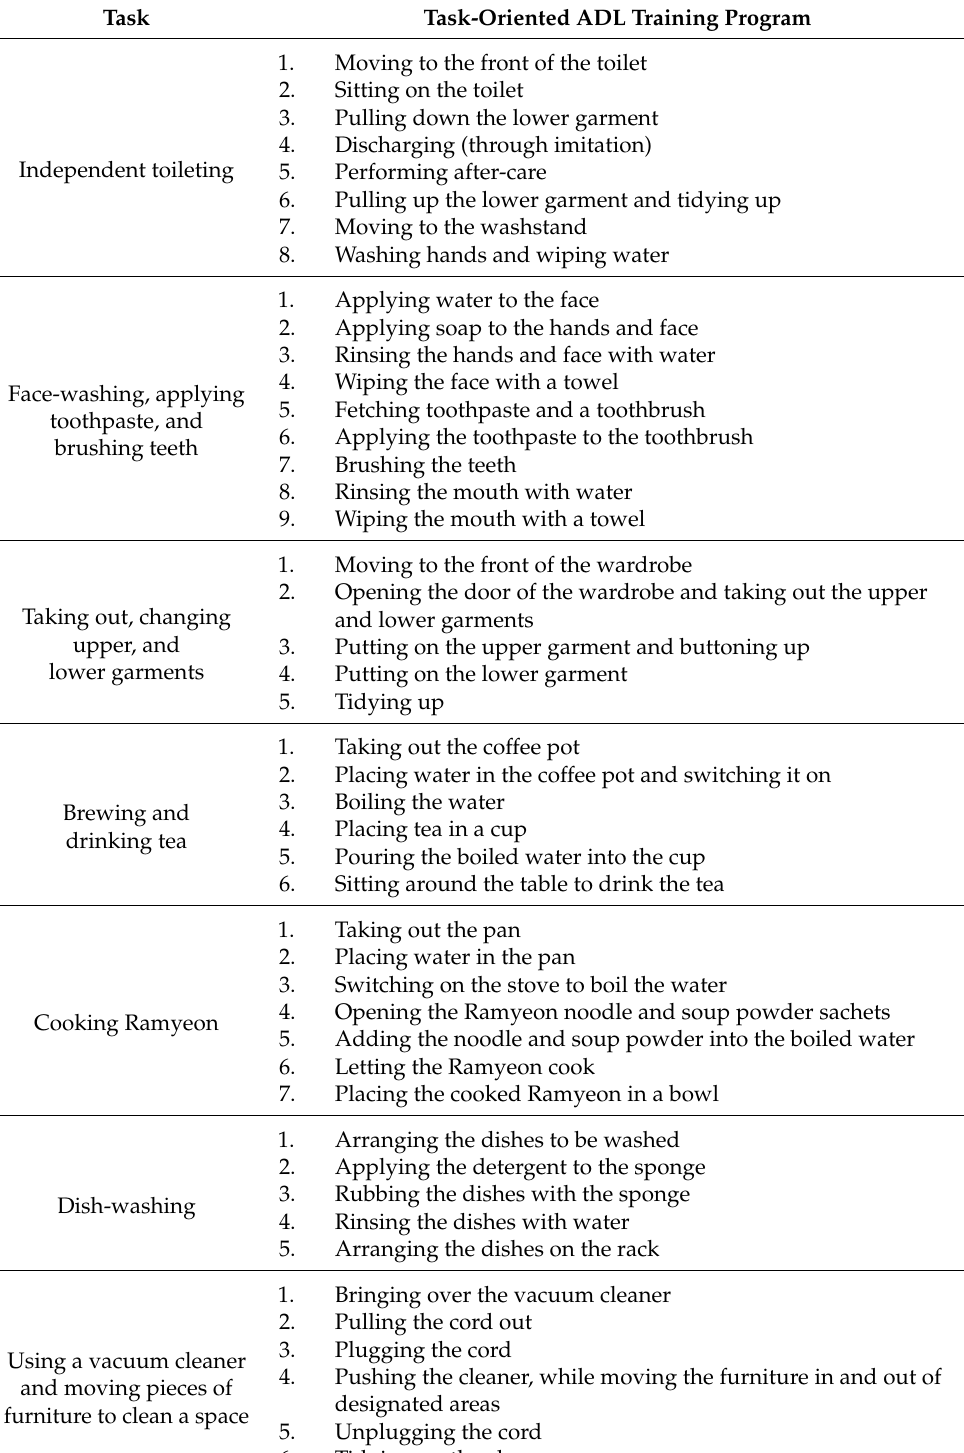
Table 1. Task-oriented ADL training